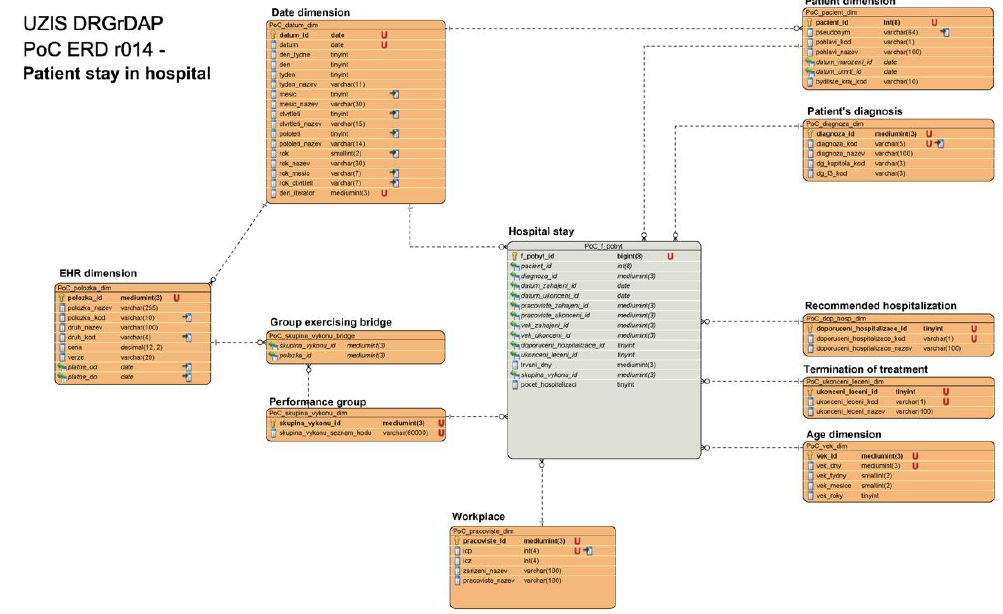
Figure A1. ER model of data warehouse related to hospitalisation duration (part I). The provided figure is intended for online viewing in high resolution.